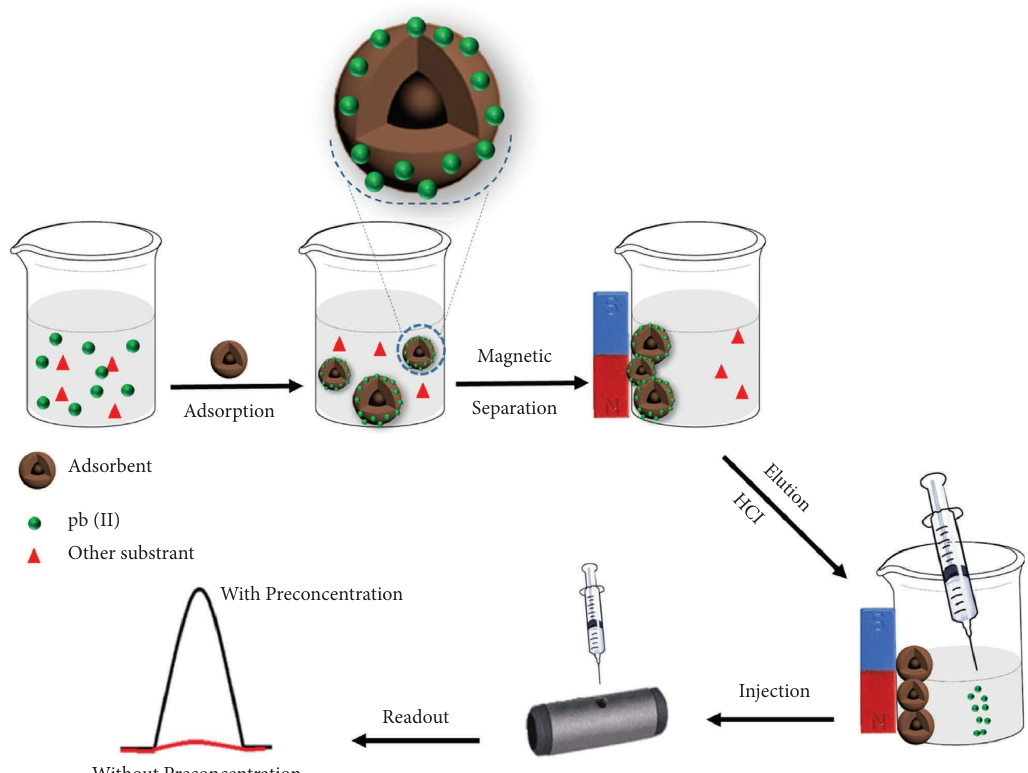
Scheme 2: Schematic diagram of the proposed strategy for preconcentration of Pb 2+